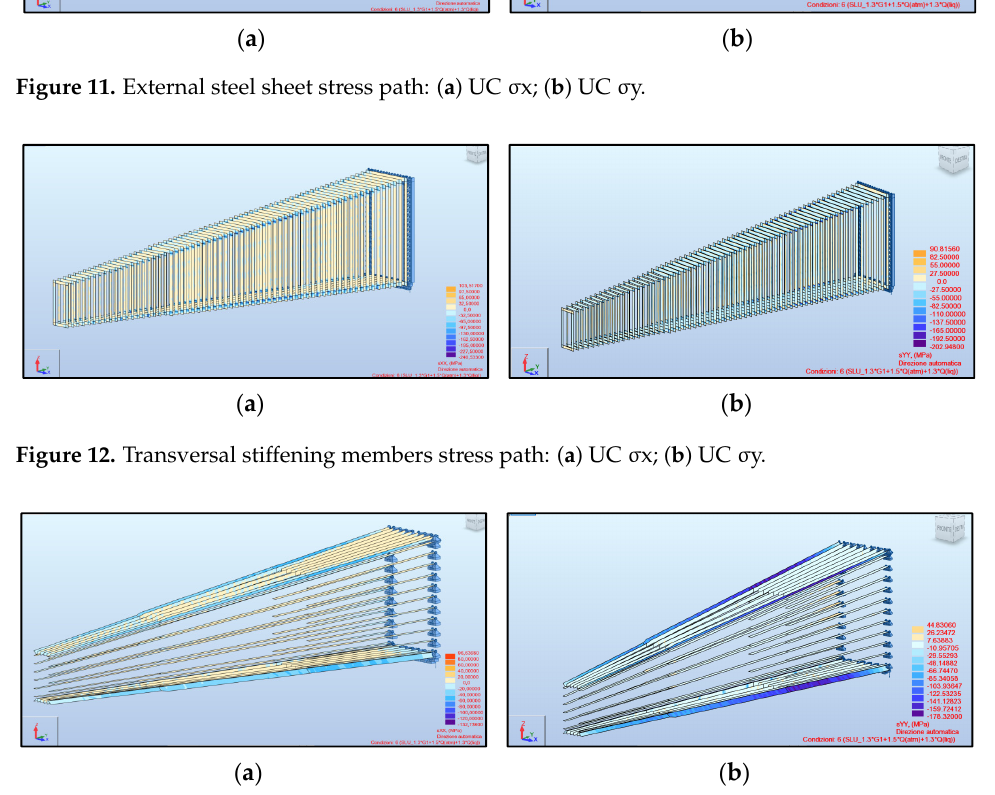
Figure 13. Longitudinal stiffening members stress path: ( a ) UC σ x; ( b ) UC σ